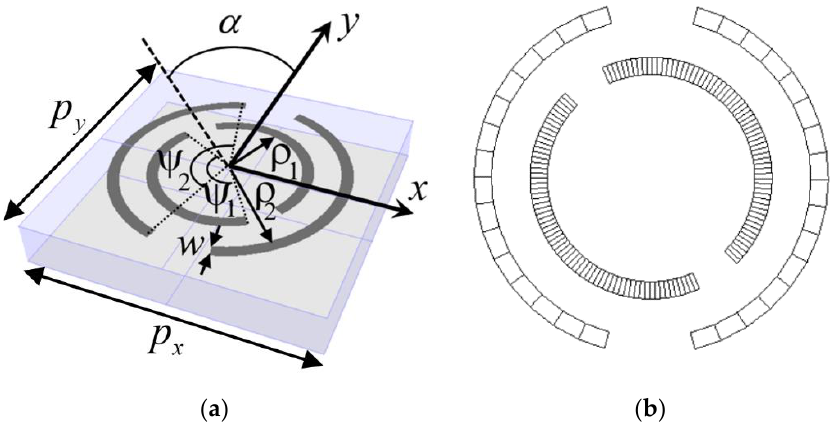
Figure 3. ( a ) Unit cell of the periodic structure based on dual concentric split-rings. ( b ) Discretization in terms of Bézier